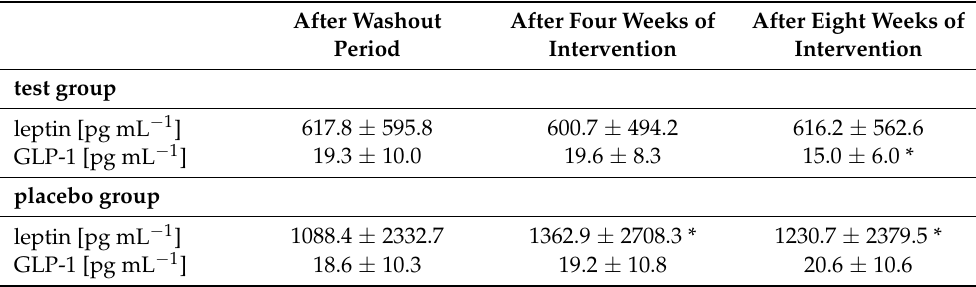
Table 5. The mean plasma leptin and glucagon-like peptide-1 (GLP-1) concentrations after the washout period, as well as after four- and eight-weeks intervention period of 750 mL polyphenol- rich beverage or placebo drink. The values are shown as means ± SD. Significant differences in comparison to the washout period: * p < 0.05.